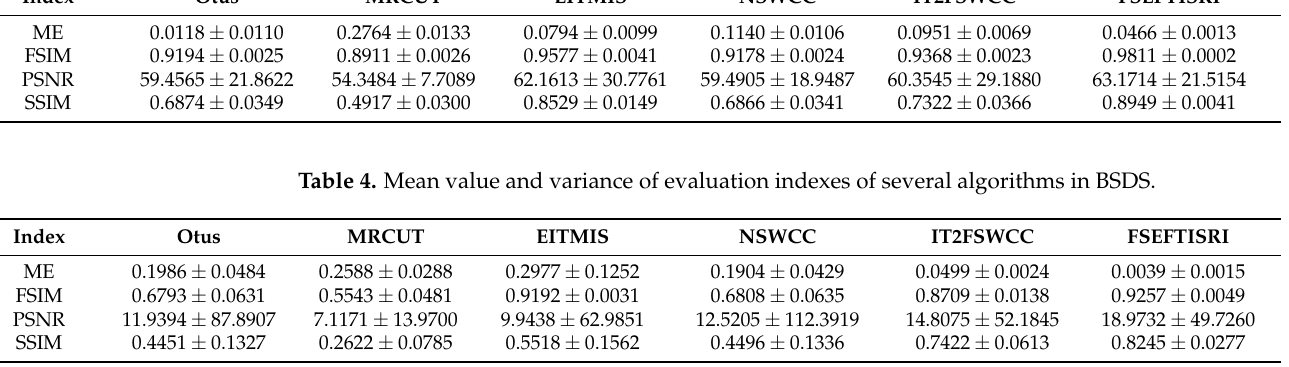
Table 3. Mean value and variance of evaluation indexes of 6 algorithms in NDT images.